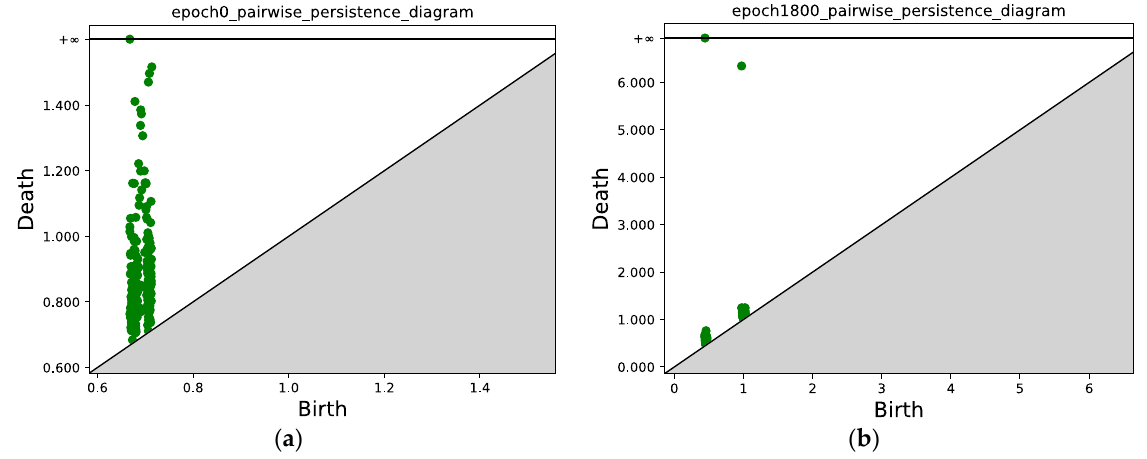
Figure 10. ( a ) Persistence diagram obtained via persistent homology at epoch 0. ( b ) Persistence diagram after 1800 epochs. Two connected components can be identified; the points with x ≈ 0.5 correspond to the first connected component (class 1), and the points with x ≈ 1.0 correspond to the second connected component (class 2).